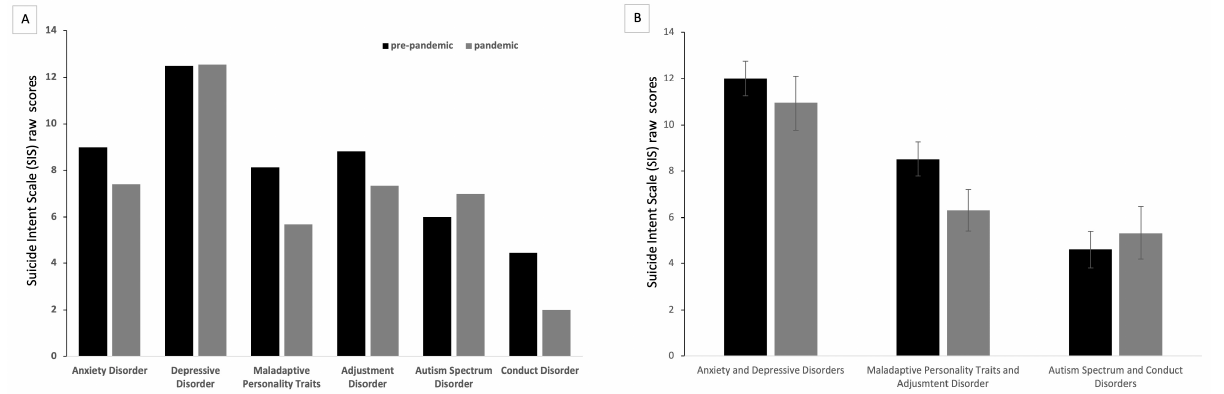
Figure 1. ( A ) Bar chart with the mean scores for Suicide Ideation Scale (SIS) in the two groups (pre-pandemic and pandemic periods) via diagnosis. ( B ) Bar chart with the mean scores and standard error of the mean (SEM) for SIS via diagnoses as grouped for the generalized linear model.